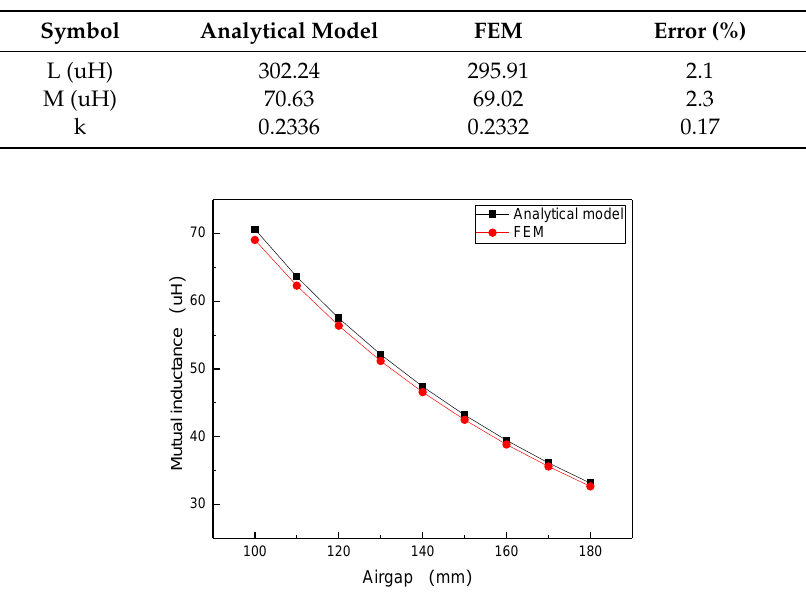
Table 2. Verification parameter of the square coil.